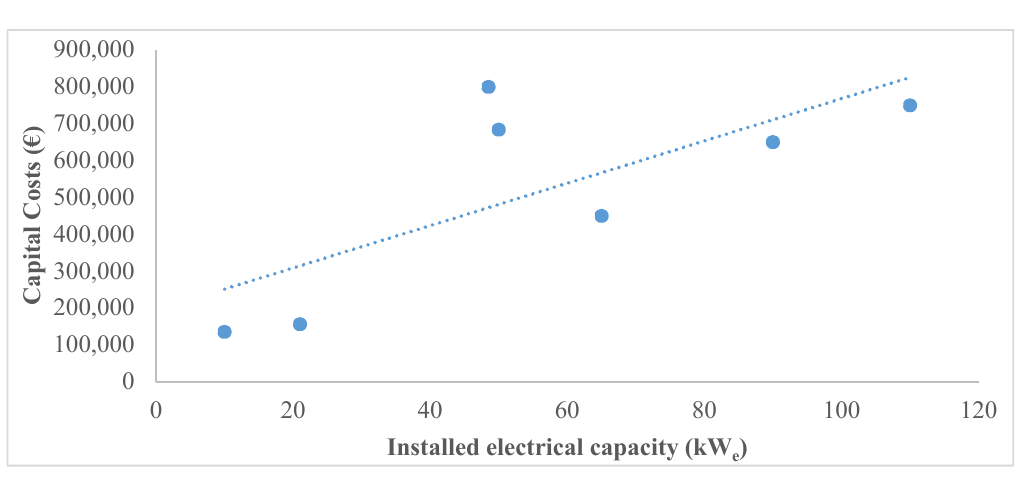
Figure 3. Establishment cost for farm-scale anaerobic digestion plants. Estimated, based on reports from [62–69].